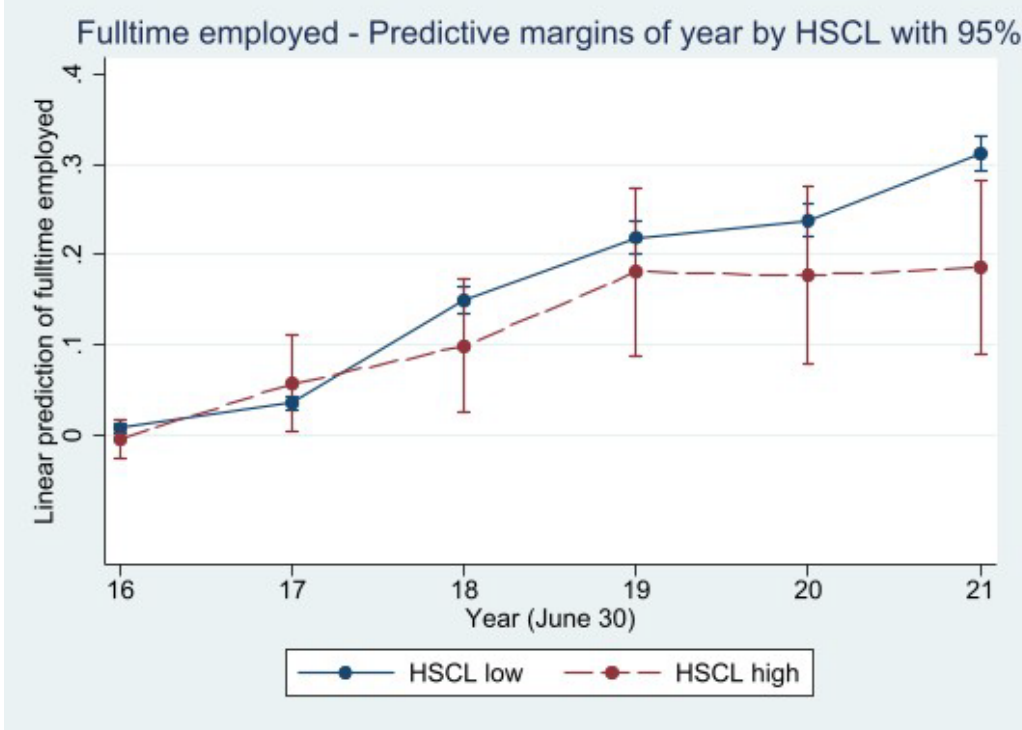
Figure 4. Linear prediction of full-time employment by mental disorder screening diagnosis—2016– 2021. Source: IAB-WELLCOME study wave 1; IEB, V16.01